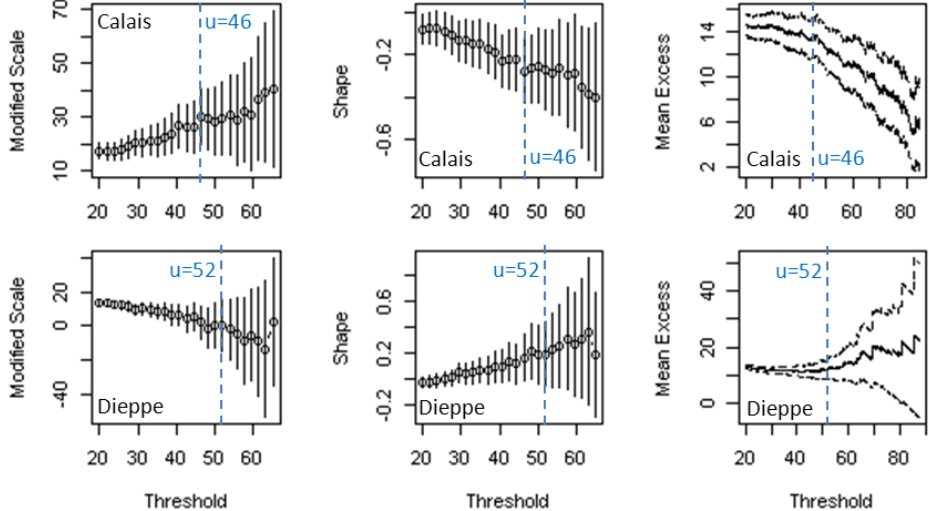
Figure 3. Estimation of u (threshold – cm): the GPD modified scale and shape parameters and mean excess life plot with 95% confidence intervals (Calais and Dieppe